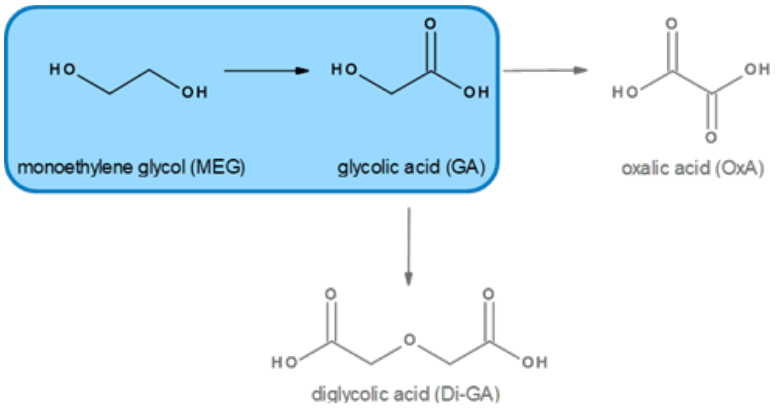
Figure 1. Reaction scheme of the oxidation of monoethylene glycol (MEG) to glycolic acid (GA) and possible side reactions.